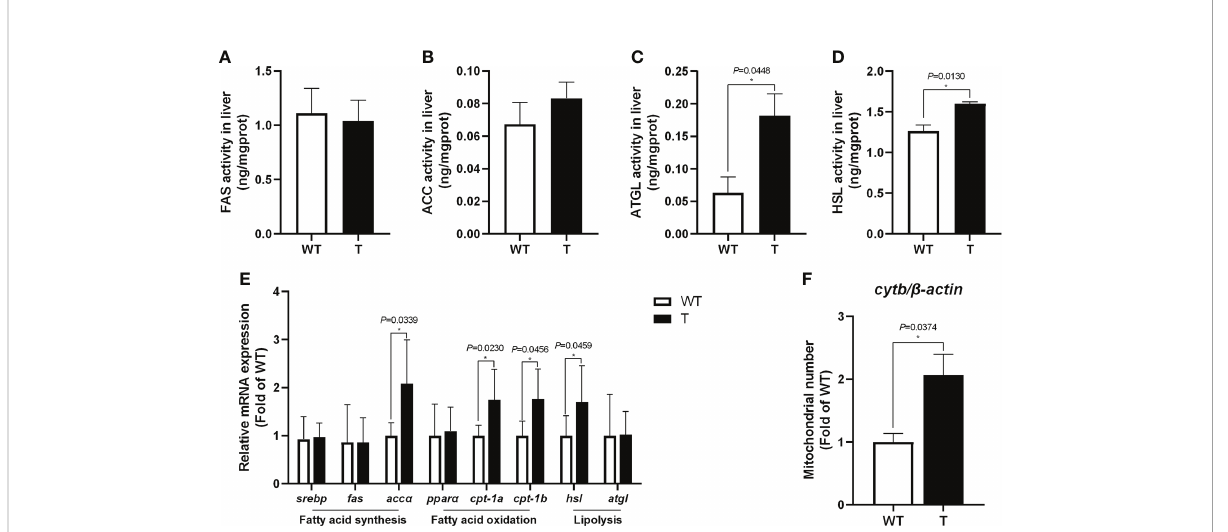
FIGURE 3 Effects of GH overexpression on enzymatic activities and relative expression level of genes related to lipid metabolism in common carp. (A – D) Enzymatic activities of fatty acid synthase (FAS), acetyl-CoA carboxylase (ACC), adipose triglyceride lipase (ATGL), and hormone-sensitive lipase (HSL) in the liver of wild-type (WT) and GH transgenic (T) common carp (n = 6). (E) Relative expression level of genes involved in lipid metabolism in the liver of WT and T common carp (n = 6). (F) Mitochondrial copy number in the liver of WT and T common carp (n = 6). * indicates 0.01< P <0.05 between WT and T common carp.